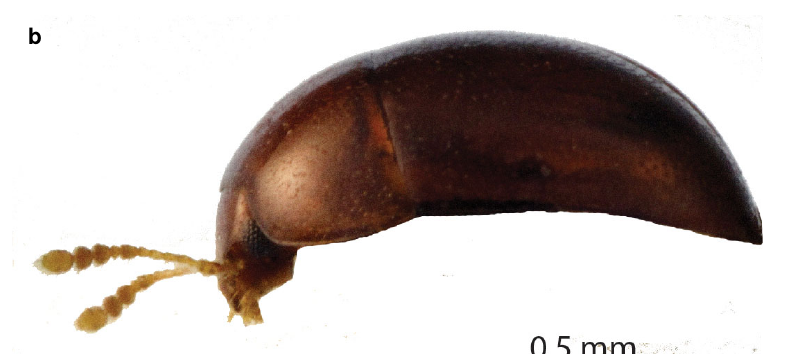
Figure 6. Dermatohomoeus maliauensis sp. n., habitus. a : Female, dorsal view (paratype, BOR/COL/14093) b : Female, lateral view (paratype,